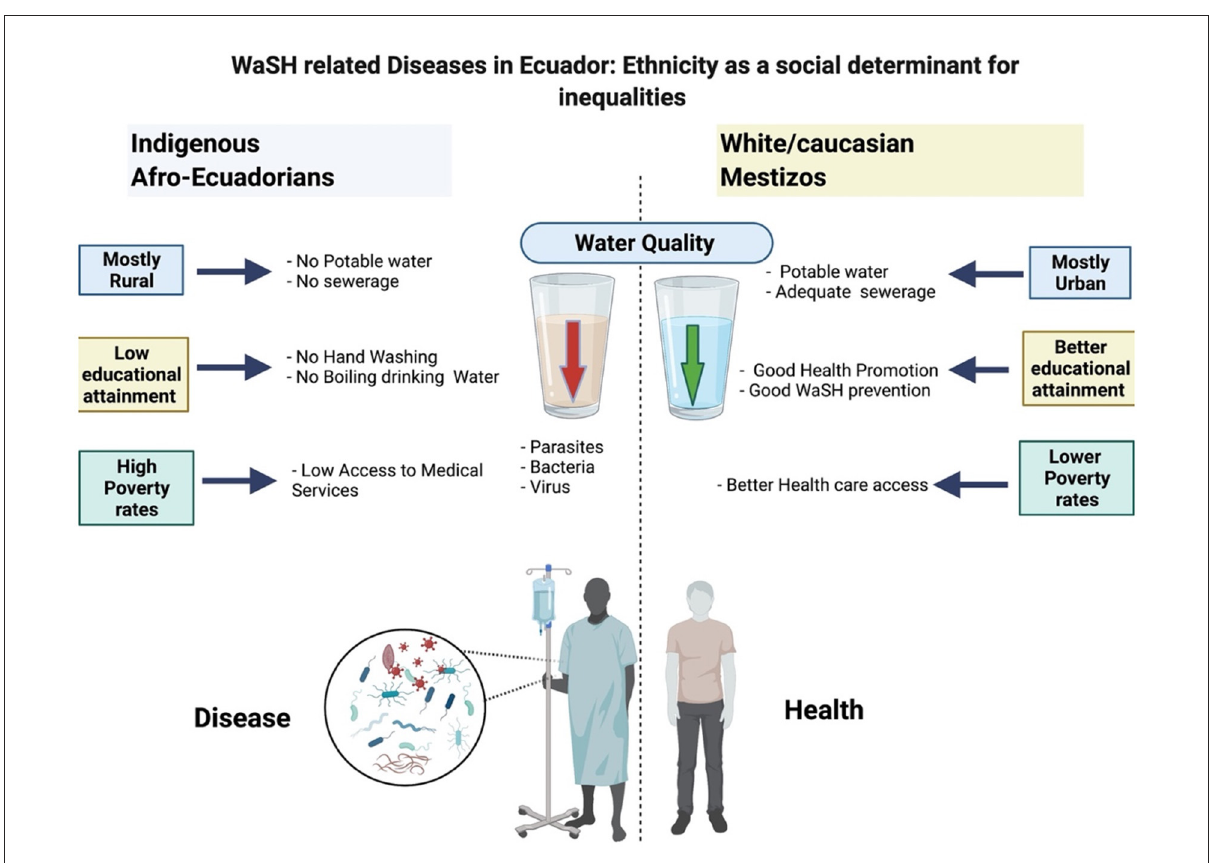
FIGURE5 Conceptual framework of the relationship between social determinants of health and water related